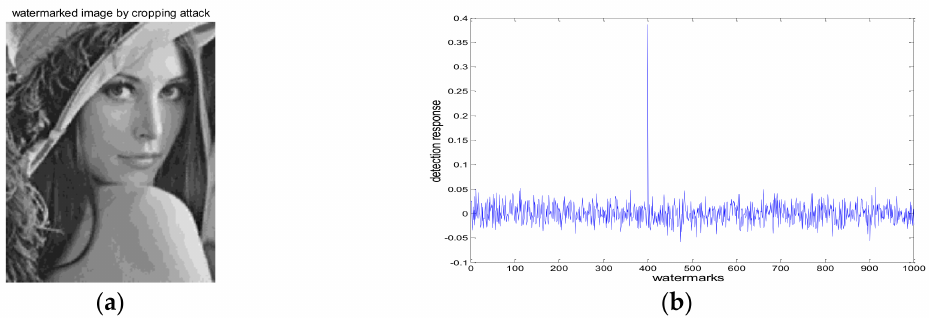
Figure 11. ( a ) Cropping attack; ( b ) detector response.